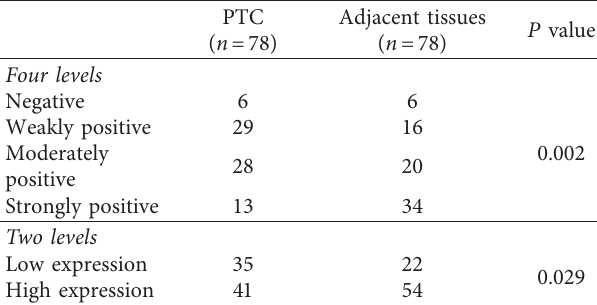
Figure 2: Differential protein expression of TNRC6C in PTCs and corresponding adjacent noncancerous tissues by immunohistochemical analysis. (a) Representative IHC images of three paired PTC tissues and adjacent noncancerous tissues. Scale bars indicate 200 um. (b) Scatter plot of TNRC6C protein expression presented as H-score in PTC tissues and adjacent noncancerous tissues. (c) Before–after graph of TNRC6C protein expression presented as H-score in PTC tissues and adjacent noncancerous tissues. Table 1: Differential protein expression of TNRC6C in PTCs and corresponding adjacent noncancerous